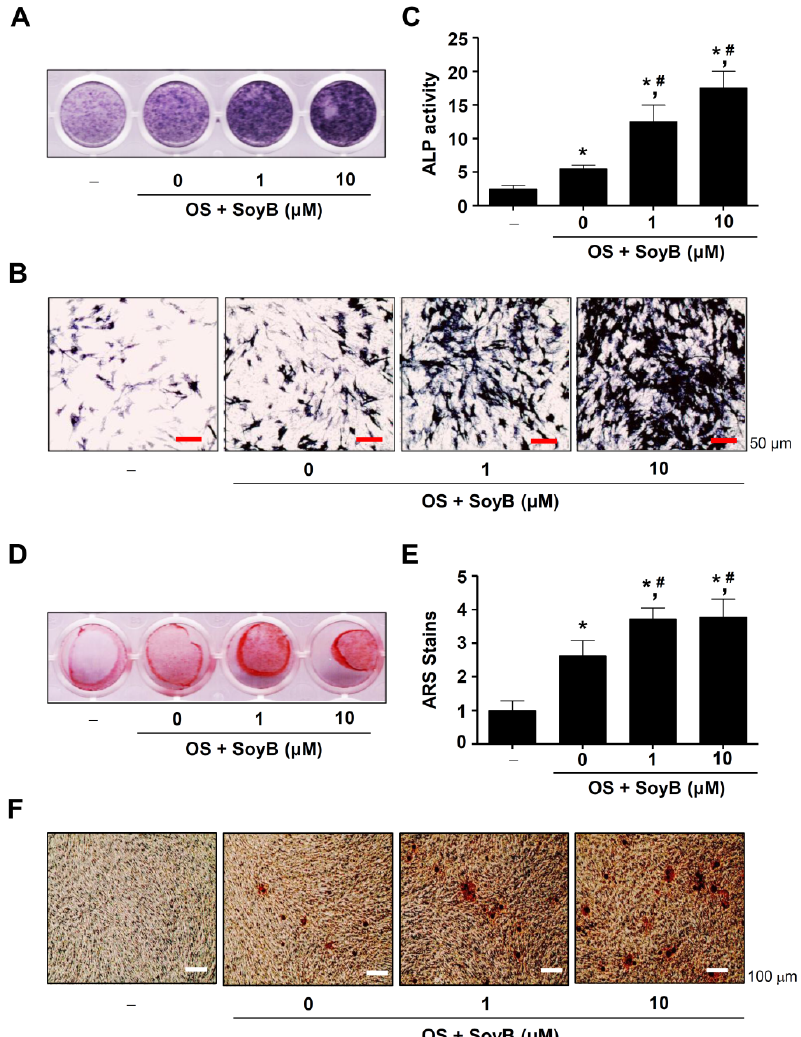
Figure 2. Effects of SoyB on early and late osteogenic activities. ( A – C ) After MC3T3-E1 cells were cultured in OS with SoyB at concentrations of 0, 1, or 10 µ M for 7 days, early osteogenic activities were detected using ALP staining assays ( A ) and ALP enzyme activity ( C ) assays, and the individual ALP-stained cells were visualized under a light microscope. ( B ) Scale bar: 50 μ m. ( D – F ) Late osteogenic activities were detected using ARS staining assay for 21 days ( D ), the ARS staining was quantitatively measured using a spectrophotometer ( E ), and the mineralization was visualized under a light microscope ( F ). Data are presented as the mean ± S.E.M. from three independent experiments. *, p < 0.05 was considered statistically significant when compared to the control. #, p < 0.05 was considered statistically significant when compared to OS.